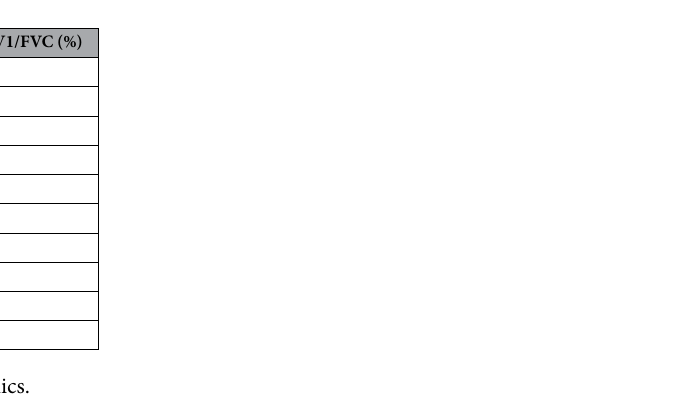
Table 1. Participant